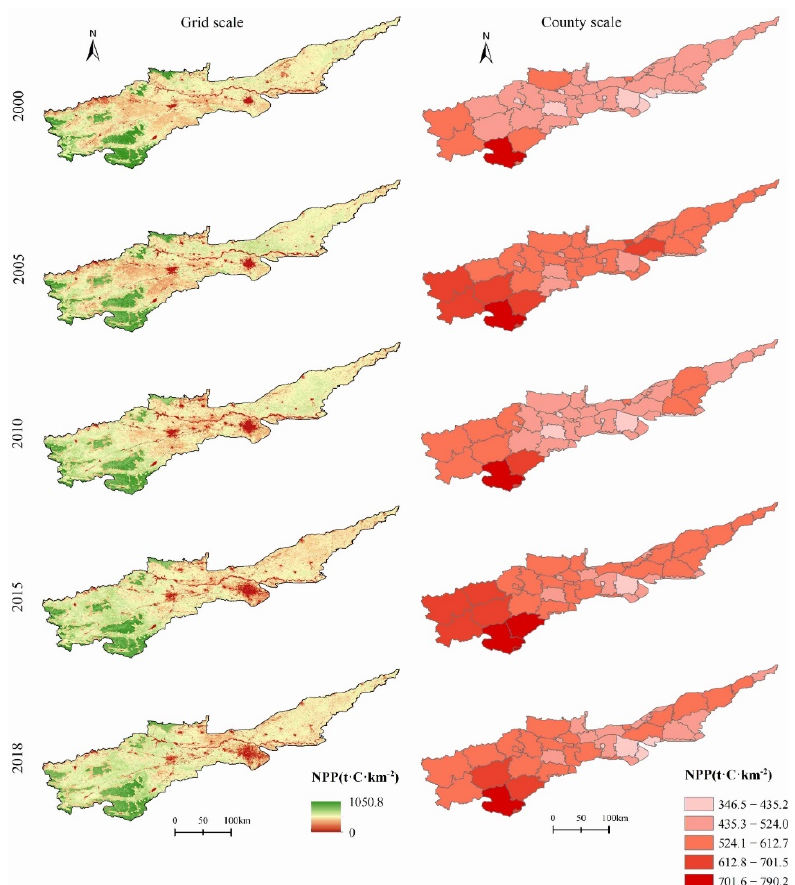
Figure 3. Spatiotemporal distribution patterns of NPP in the AYRHP on grid and county scales.